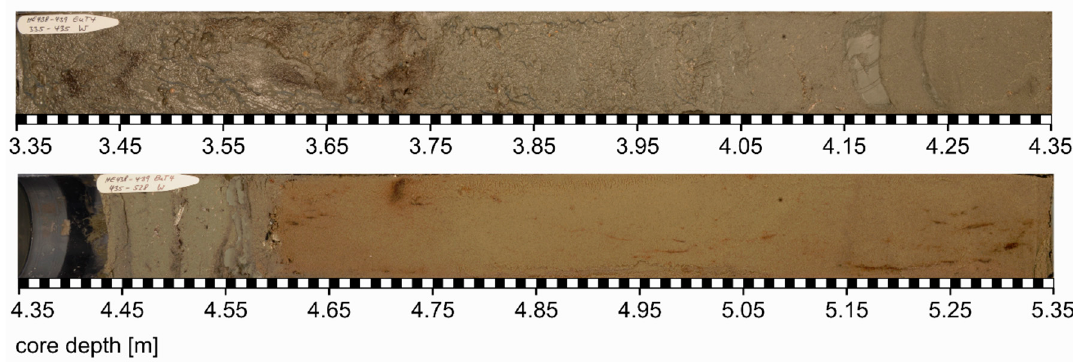
Figure 7. Photographs of Sections 4 and 5 (3.35–5.35 m) of core 4. Significant changes in sediment characteristics existed between 4.0 m and 4.6 m.